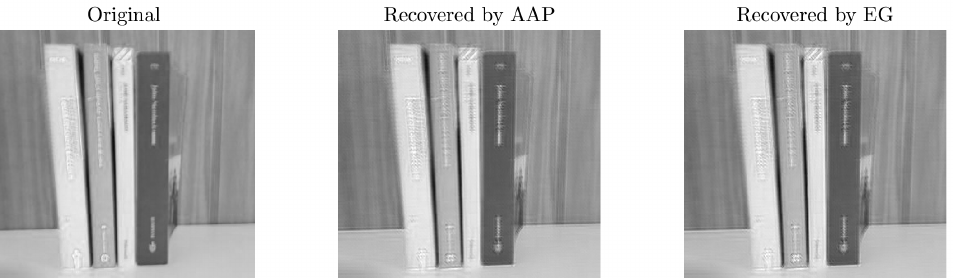
Figure 11. Image naturally blurred taken non-frontally through an out-of-focus lens. From left to right: Recorded image, image deblurred by the adapt-and-project method and image deblurred by the exponentiated-gradient